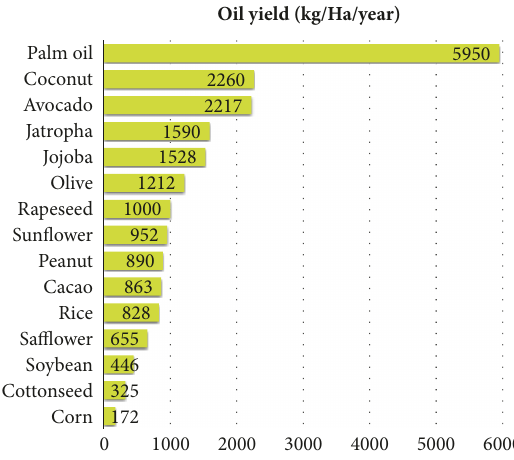
Figure 2: Annual oil yields of different vegetable crops. Adapted from Tickell et al. [33] and Ma et al. [31].